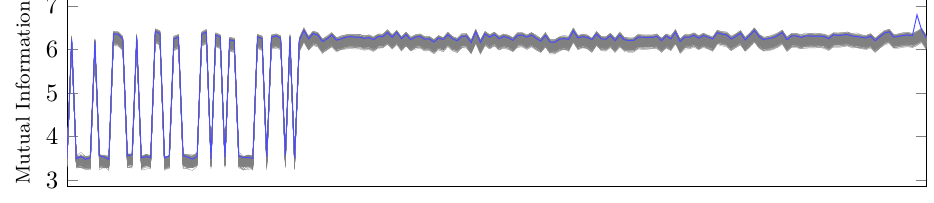
Figure 8: Mutual information traces for the correct key guess (in blue) and 256 (out of 2 16 − 1) incorrect key guesses (in